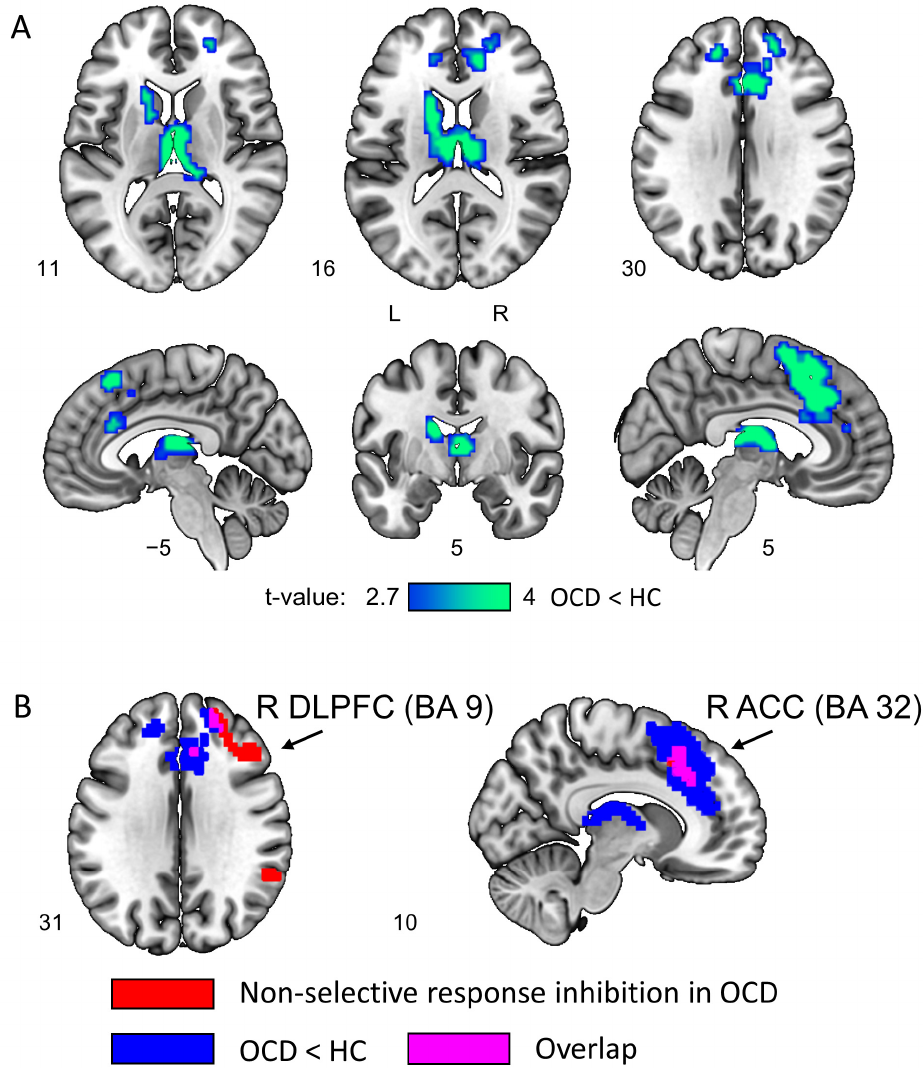
Figure 3. ( A ) Hypoactive brain areas during equiprobable Go/NoGo task performance in the OCD group compared to the HC group (“Go + NoGo” contrast). Cluster-level FWE-corrected threshold of 0.05. ( B ) Nodes of the non-selective response inhibition system in patients with OCD (red color), hypoactivated brain areas in OCD (blue color), and the overlap between them (violet color). Table 2. Decreased BOLD ‐ signal in equiprobable Go and NoGo trials (“Go + NoGo” contrast) in the OCD group compared to the HC group. Cluster ‐ level FWE ‐ corrected threshold of 0.05. Cluster Size, №